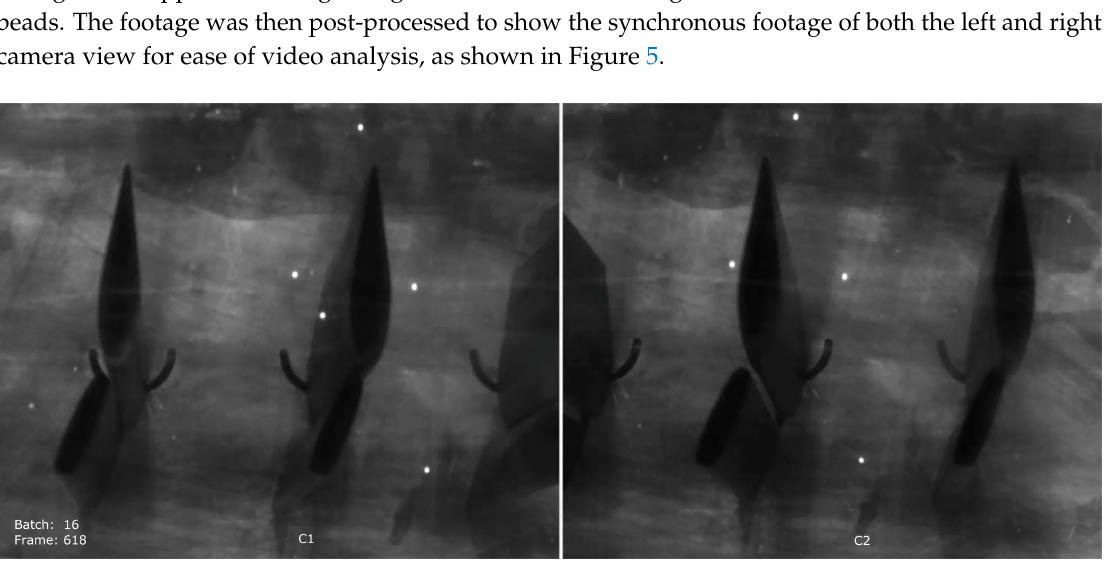
Figure 5. Dual high-speed cameras show spherical bead passage through vane array at upper 1% configuration (Test